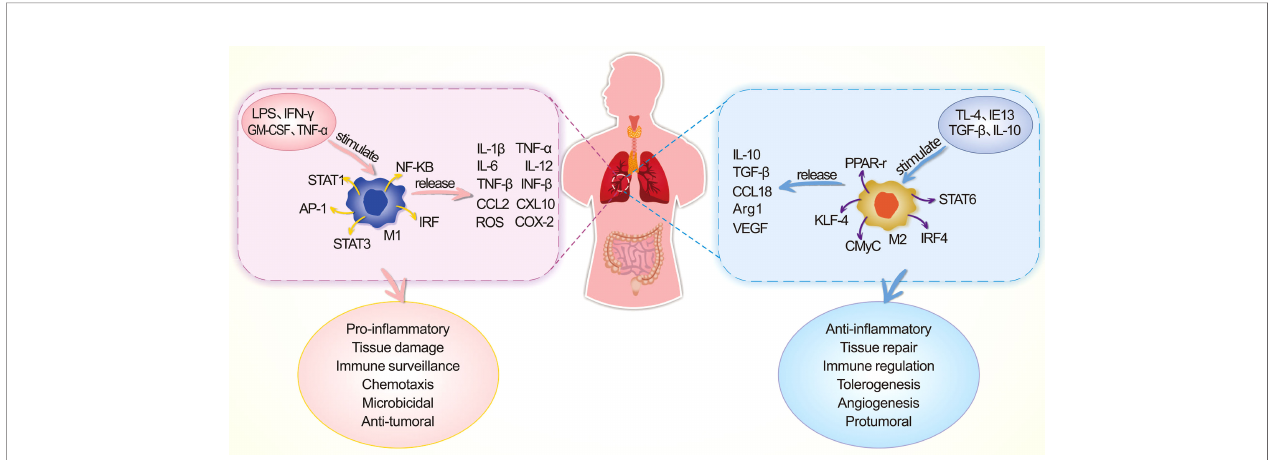
FIGURE 5 | Comparison of M1-type macrophages and M2-type macrophages, in terms of stimulatory factors, transcription factors, released mediators, and functional properties during the process of PALI. AP-1, activating protein-1; ARG1, arginase 1; CMyC, transcription factor CMyC; GM-CSF, granulocyte-macrophage colony- stimulating factor; IFN- g , interferon g ; IRF, interferon regulatory factor; KLF-4, krüppel-like factor 4; LPS, lipopolysaccharide; NF- k B, nuclear transcription factor k B; ROS, reactive oxygen species; STAT, signal transduction and activation of transcription factor; TGF- b , transforming growth factor ß; VEGF, vascular endothelial growth